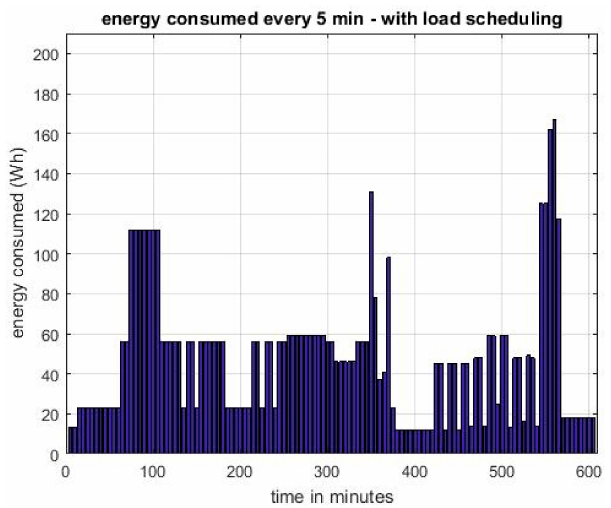
Figure 11. Energy consumption with load scheduling and